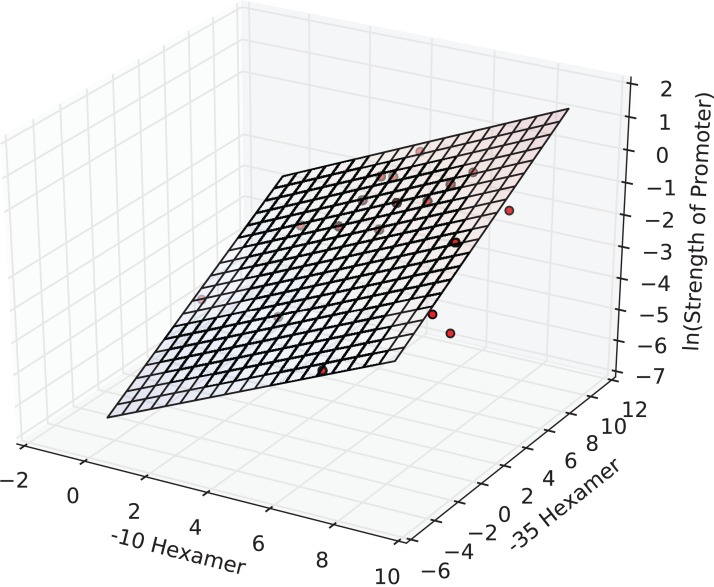
The regression surface of the estimated model with the training data points (red).x- and y-axes represent PWM scores and the z-axis (vertical) represents the predicted ln(promoter strength).